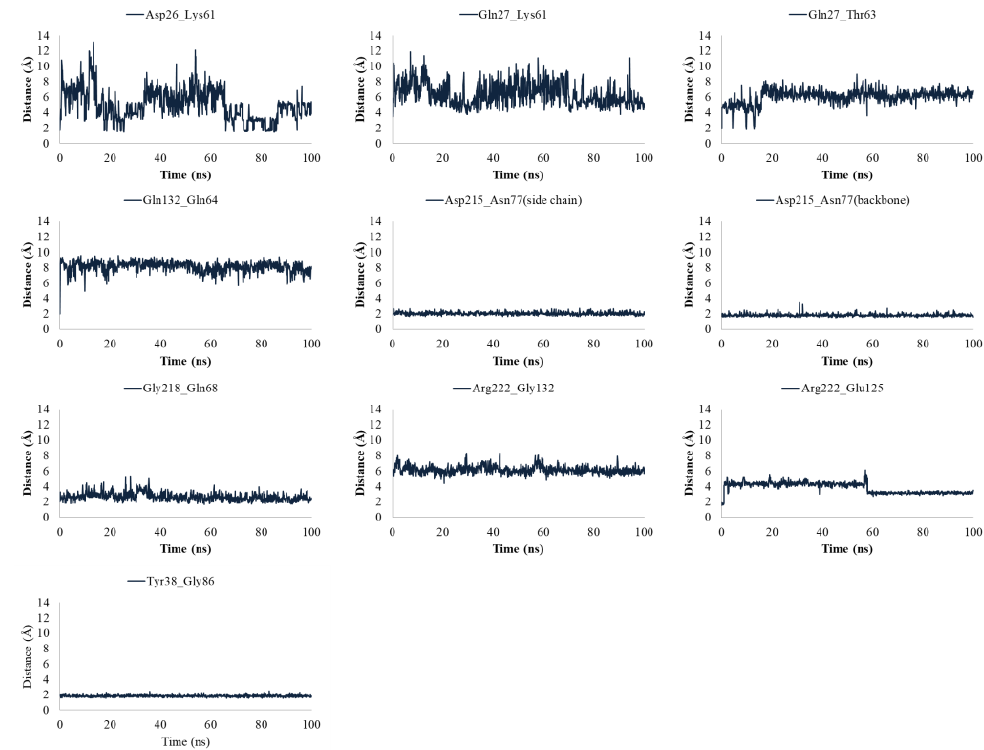
Figure 4. Plots of the distances between the residues of gD involved in the interaction at the interface with Nectin-1 after 100 ns of MDs.